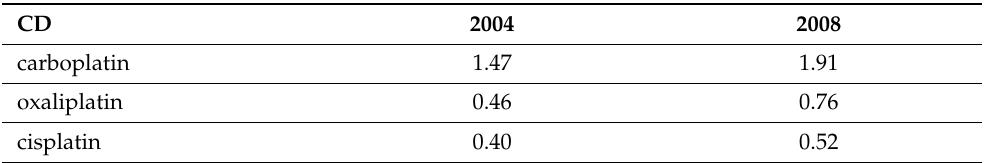
Table 1. Predicted PEC concentrations (ng L −1 ) of carboplatin, oxaliplatin, and cisplatin in France, in the years 2004 and 2008 [57].